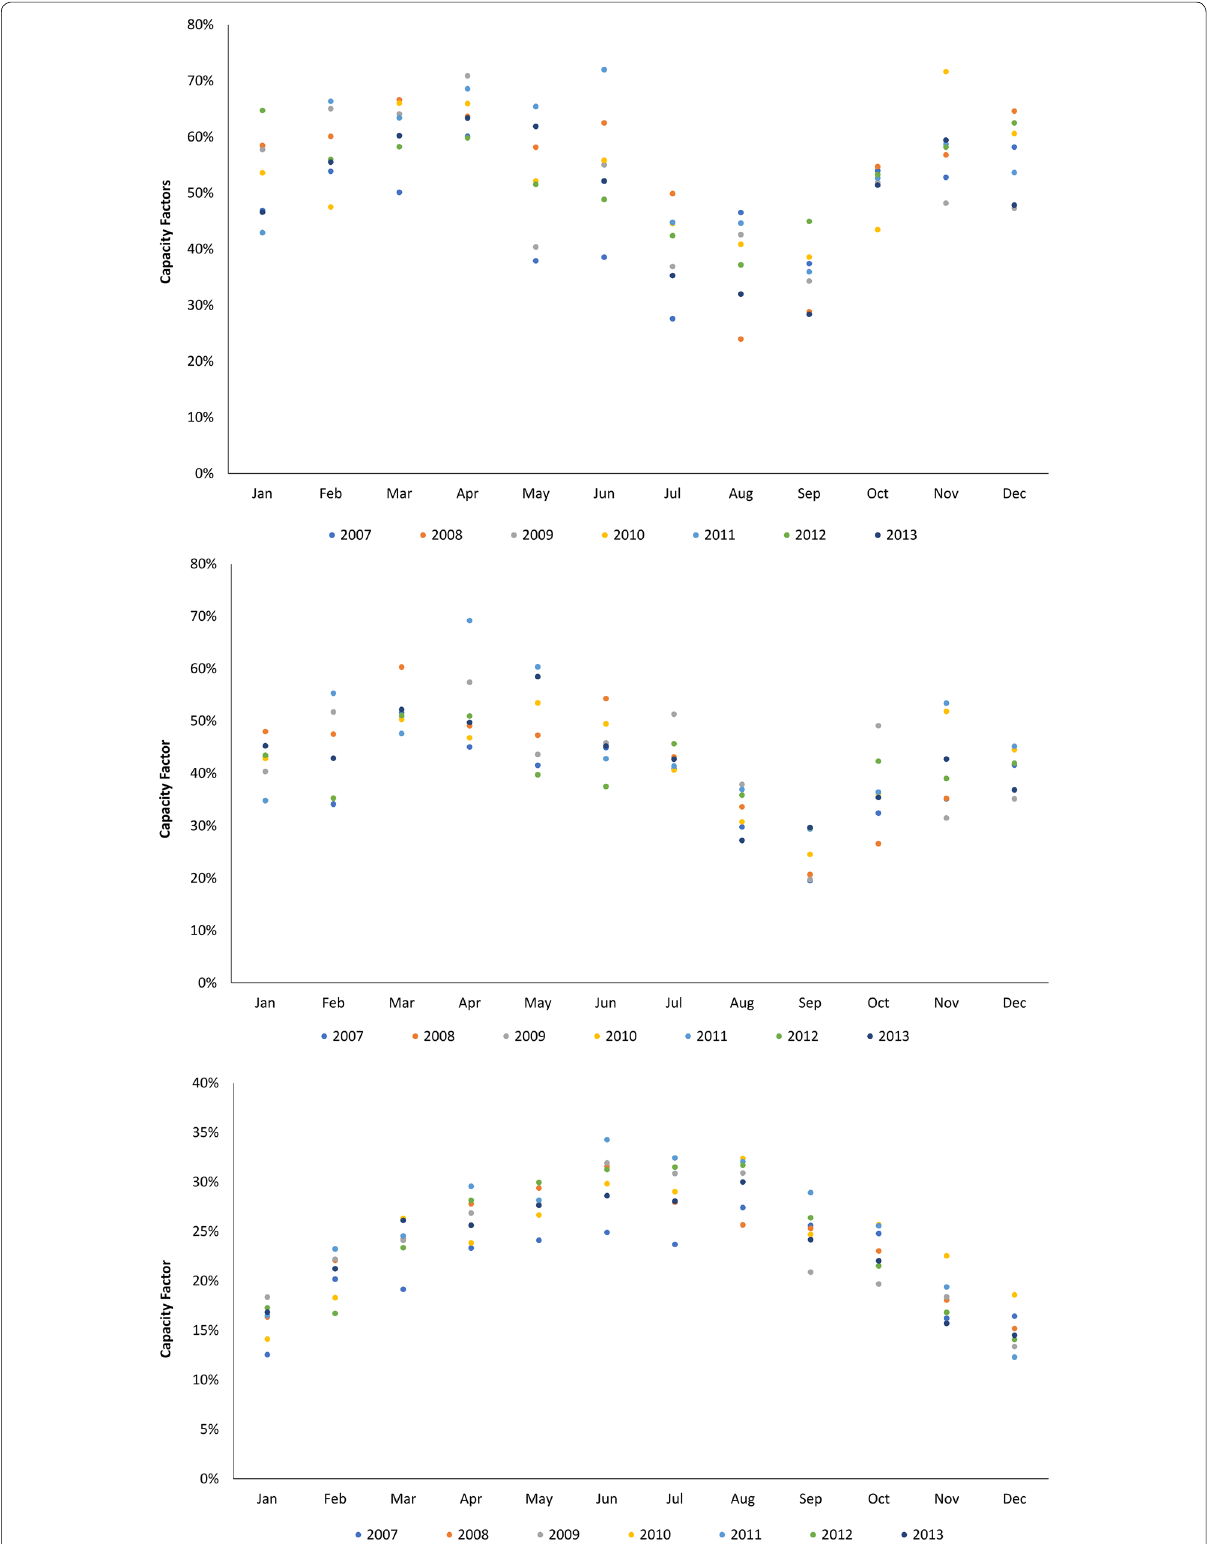
Fig. 4 Monthly capacity factors for representative sites for Buffalo Gap (WT wind, top), Peñascal (ST wind, middle), and Alamo 5 (solar,